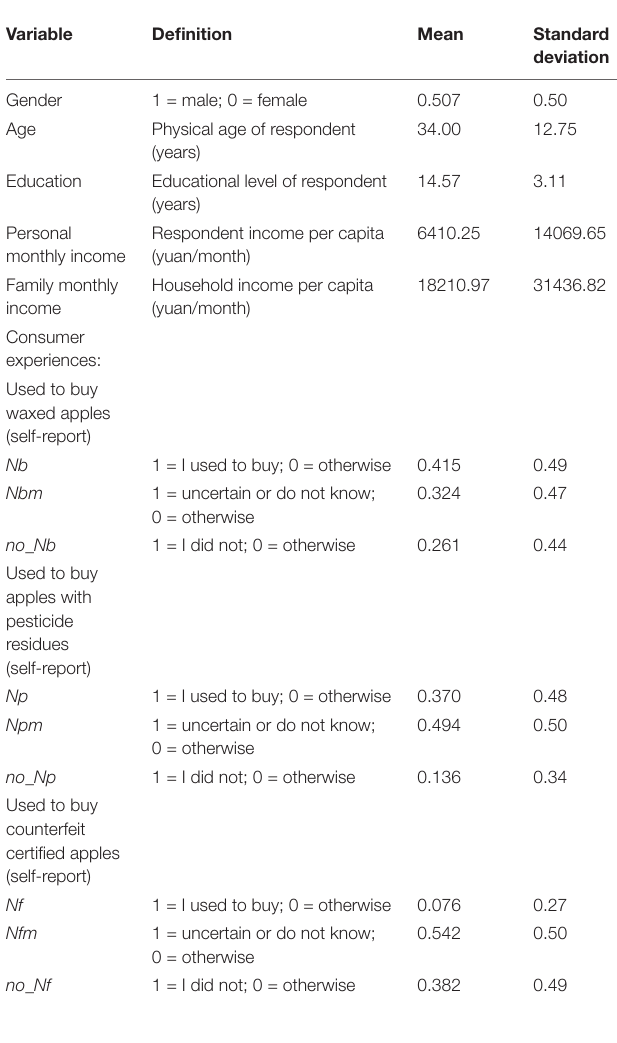
TABLE 1 | Demographic characteristics and past experiences buying Fuji apple of the